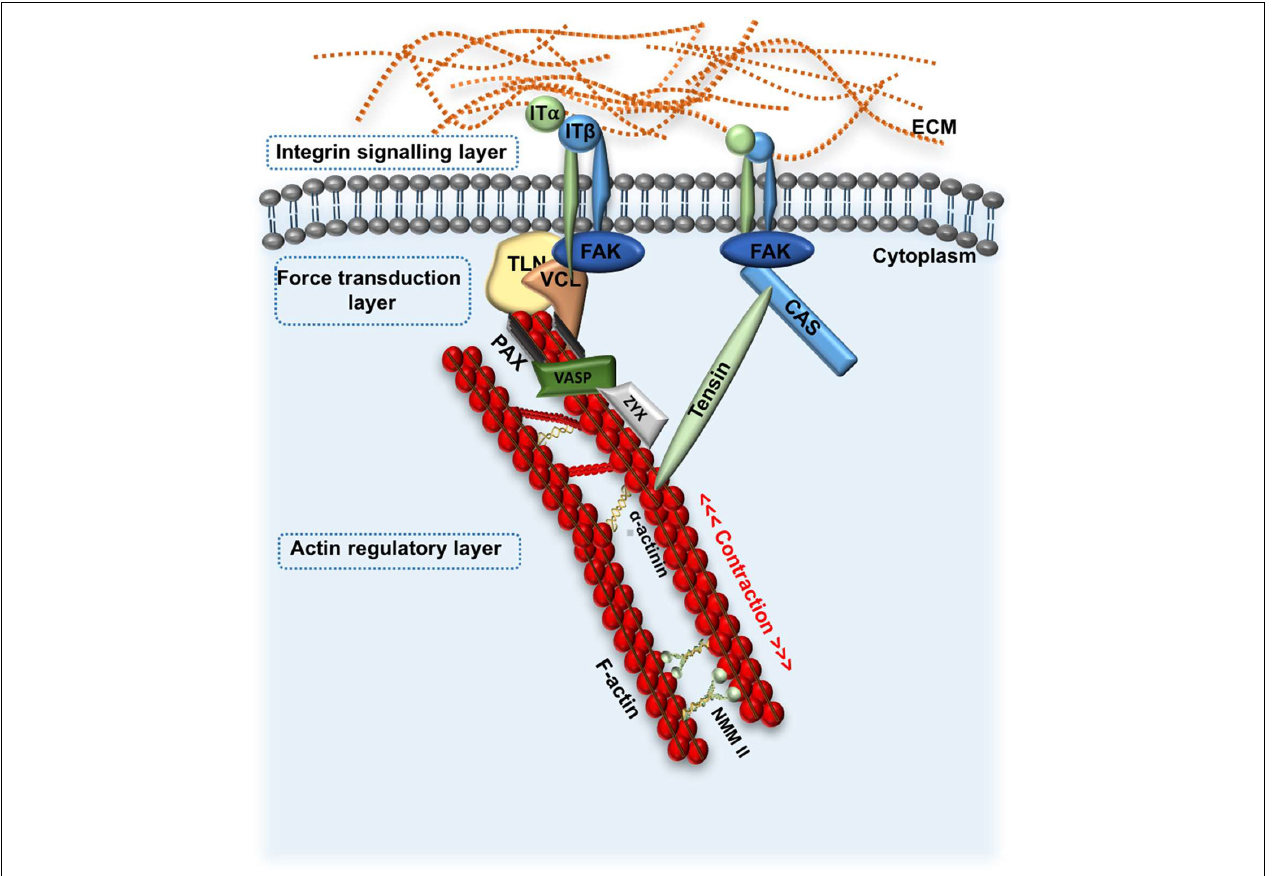
FIGURE 4 | Schematic representation of focal adhesion kinase signalling. FA signalling: FAK is recruited to integrin clusters at the cell-ECM boundary in response to changes to ECM stiffness, or other physical cues. This initiates formation of the FA complex by recruitment of various proteins such as TLN and VCL and CAS, which transduce mechanical stimuli from the ECM to the cellular cytoskeleton. VASP, Zyx and α -actinin directly regulate actin assembly. Three general FA layers are depicted, including the integrin signalling layer, force transduction layer and actin regulatory layer. FA, focal adhesion; ECM, extracellular matrix; IT α ;ITß, integrin subunit α and ß; FAK, focal adhesion kinase; TLN, talin; VCL, vinculin; Zyz, zyxin; NMM II, non-muscle myosin II; VASP, vasodilator-stimulated